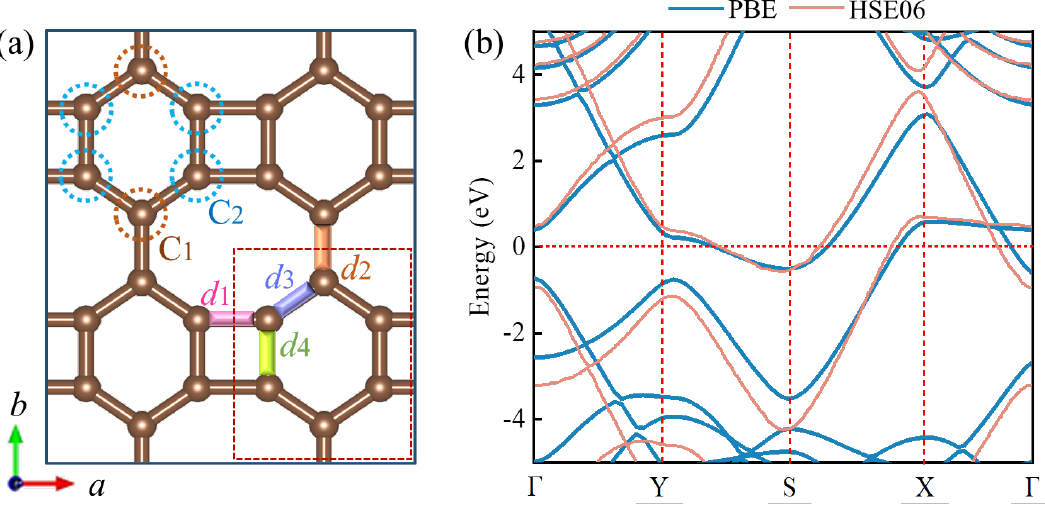
Figure 1. ( a ) Optimized structure of biphenylene. ( b ) The band structure of biphenylene calculated with PBE and HSE06.